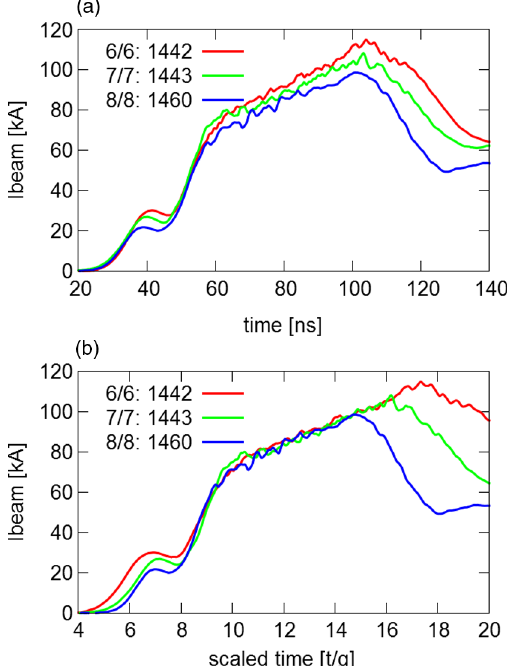
Bruner,FIG. 17. (a) The IBEAM diode currents from shots 1442, 1443, and 1460, which are 6-6, 7-7, and 8-8 configurations, respectively. (b)ThesameIBEAMcurrentswiththetimeaxesscaledby t 0 ¼ t=g 0 .